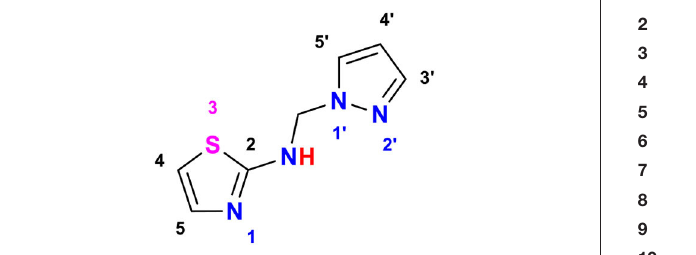
FIGURE 2 | The chemical structure of N-((1H-pyrazol-1-yl)methyl)thiazol-2- amine, 7.